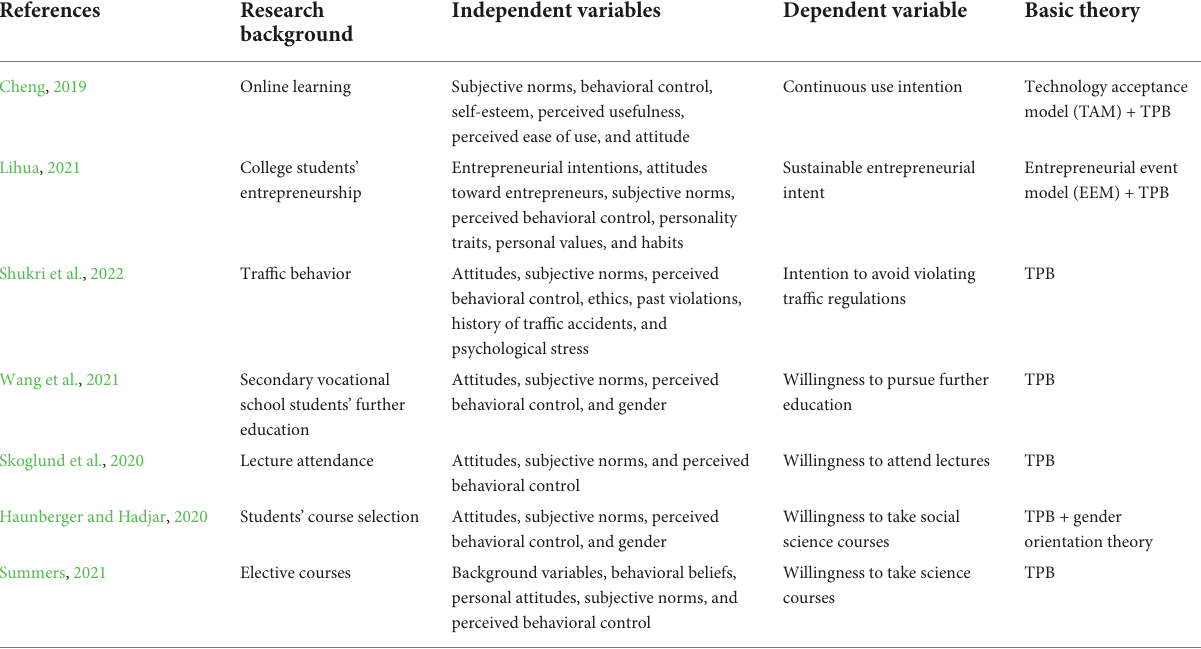
TABLE 1 Research on the theory of planned behavior